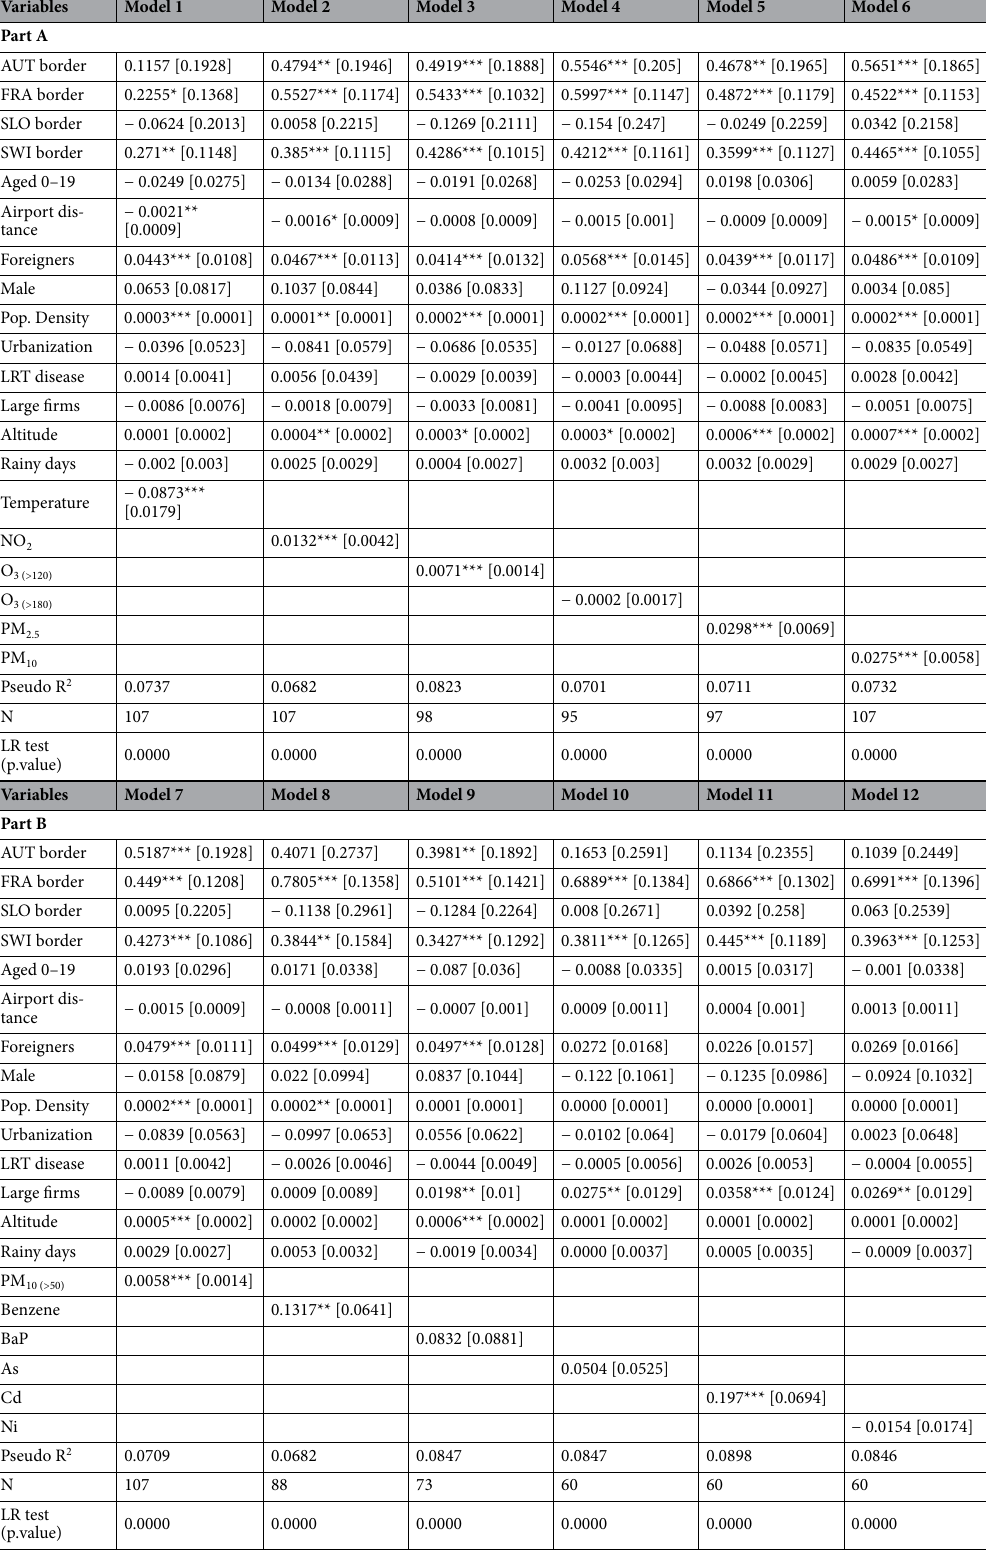
Table 6. Results from negative binomial regressions on COVID-19 cumulative cases registered on 30 November 2020. p-value < 0.01***; p-value < 0.05**; p-value < 0.1*. Standard errors in parentheses. All models included a constant, a dummy for regional capitals, and controls for the size of the province, smokers, and obese